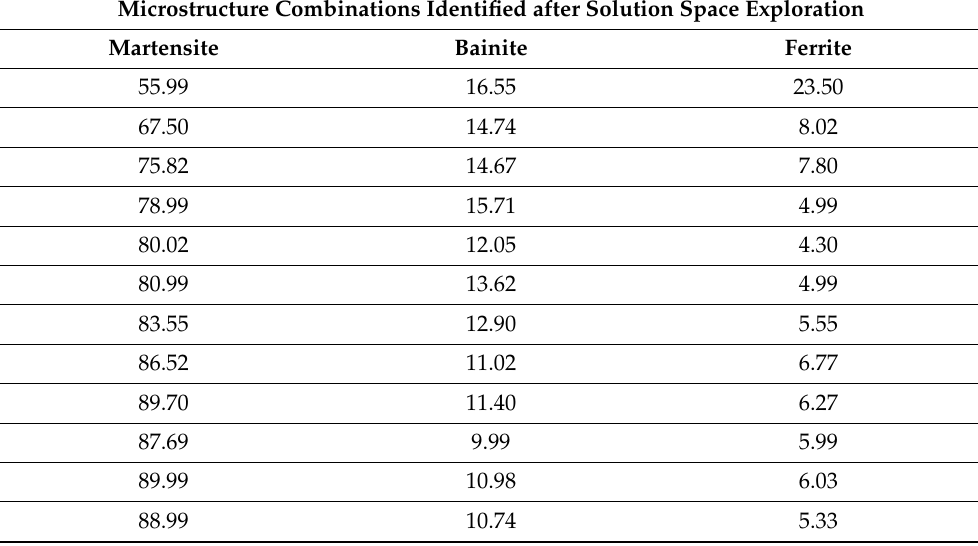
Table 8. Phase Fraction Combinations Satisfying the Requirements on Mechanical Properties.